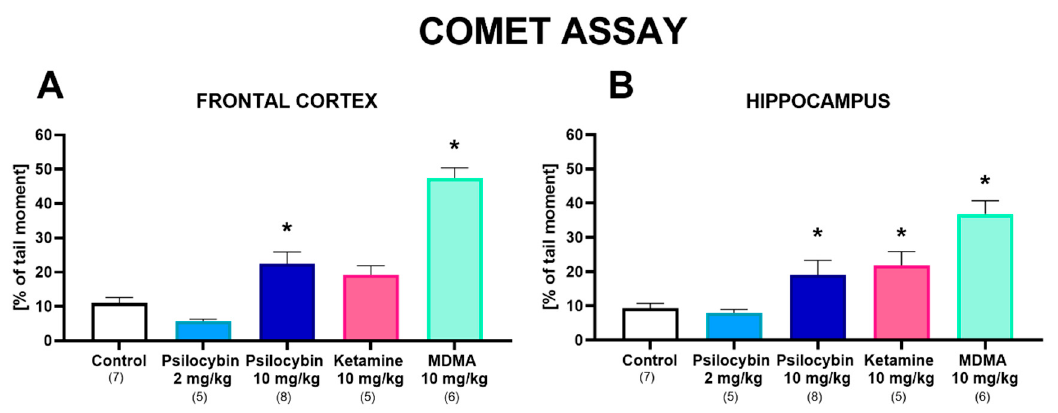
Figure 4. The effect of psilocybin (2 and 10 mg/kg), ketamine (10 mg/kg) and MDMA (10 mg/kg) on the oxidative damage of DNA in nuclei of the rat frontal cortex ( A ) and hippocampus ( B ) in the comet assay estimated 7 days after treatment. Data are the mean ± SEM (n is given under the name of the group) and represent tail moment shown as the product of the tail length and the fraction of total DNA in the tail. * p < 0.001–0.05 compared to the control (one-way ANOVA followed by Tukey’s post hoc test).